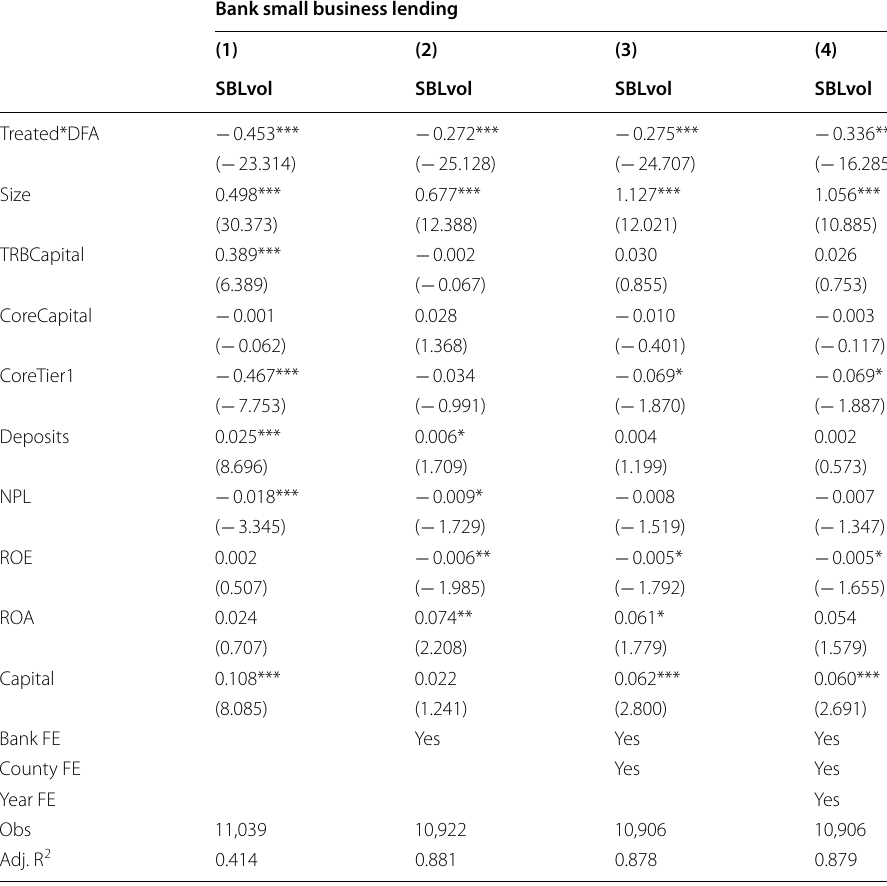
Table 8 Robustness results for bank level